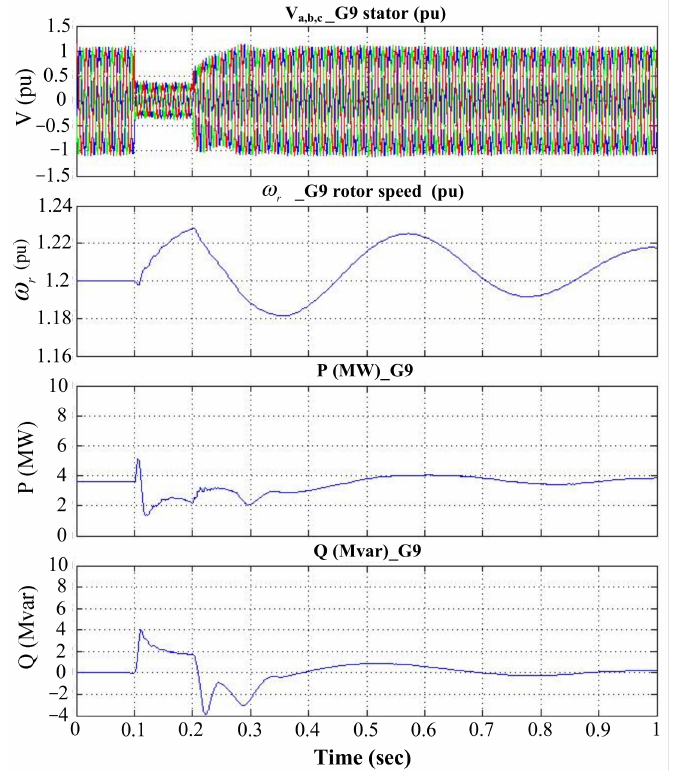
Figure 12. Responses of the G9 stator voltage, rotator speed, and real and reactive power for the STATCOM installed at bus